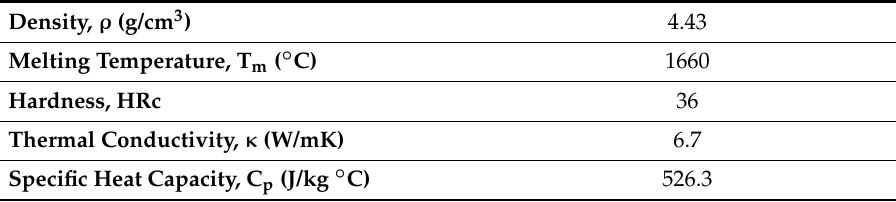
Table 2. The physical properties of Ti6Al4V titanium